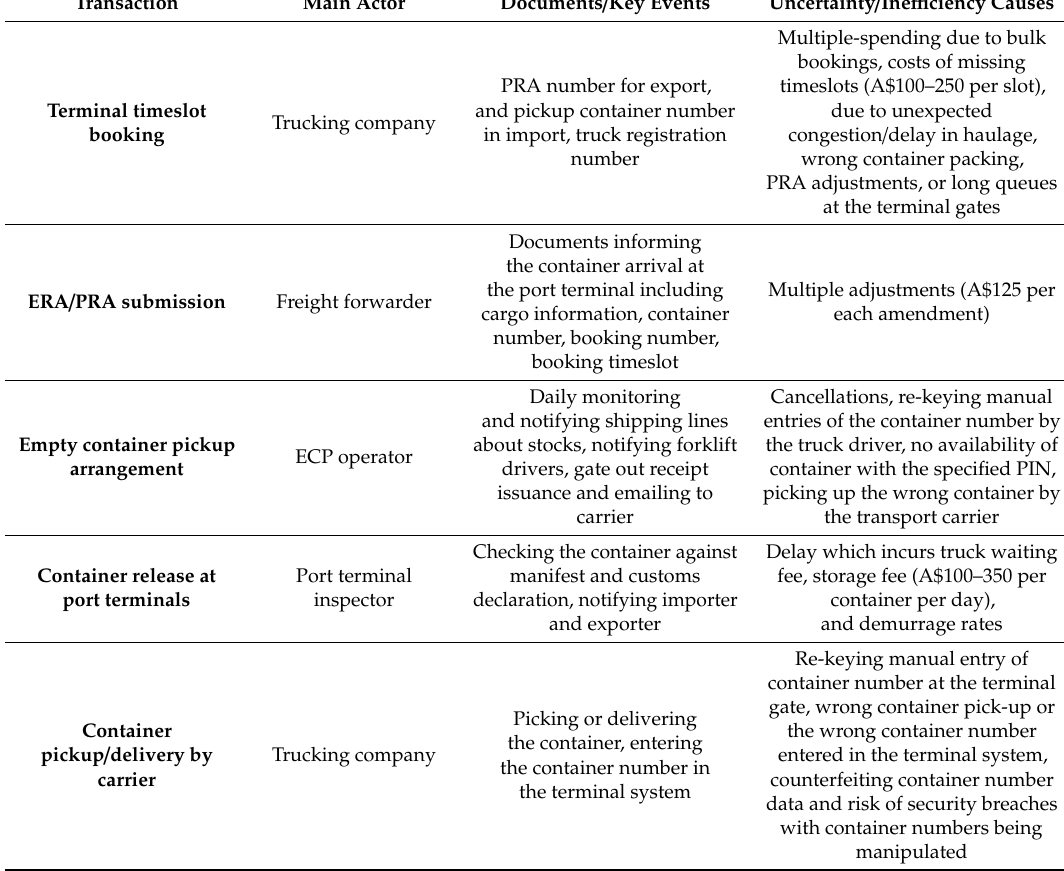
Table 5. Overview of transactions in inland haulage logistics in the status quo (developed by the